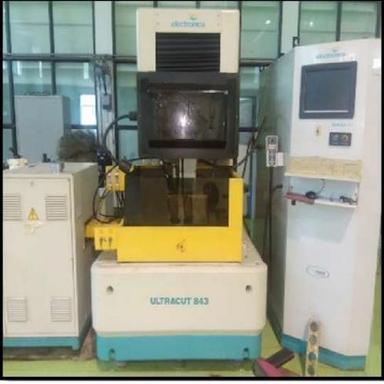
Wire-Cut EDM.